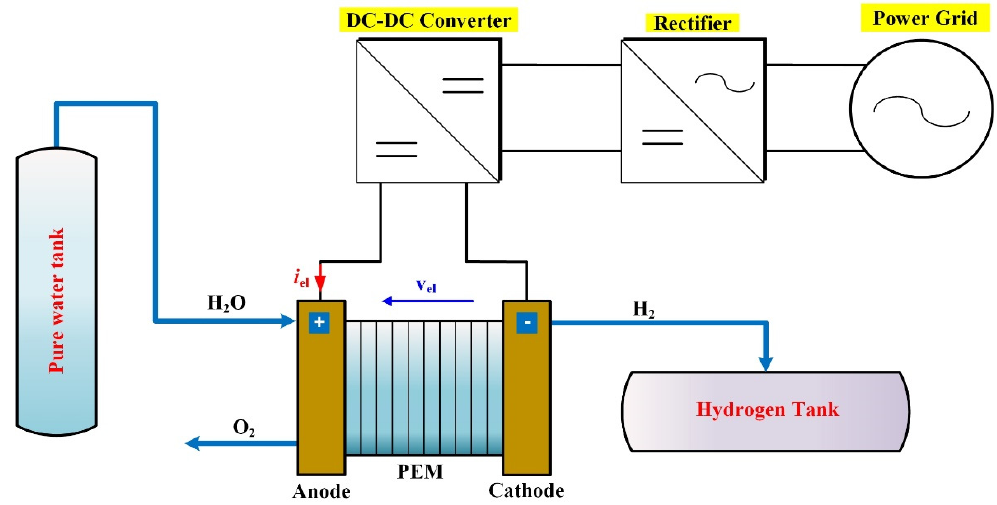
Figure 3. PEM electrolyzer system including power electronics.